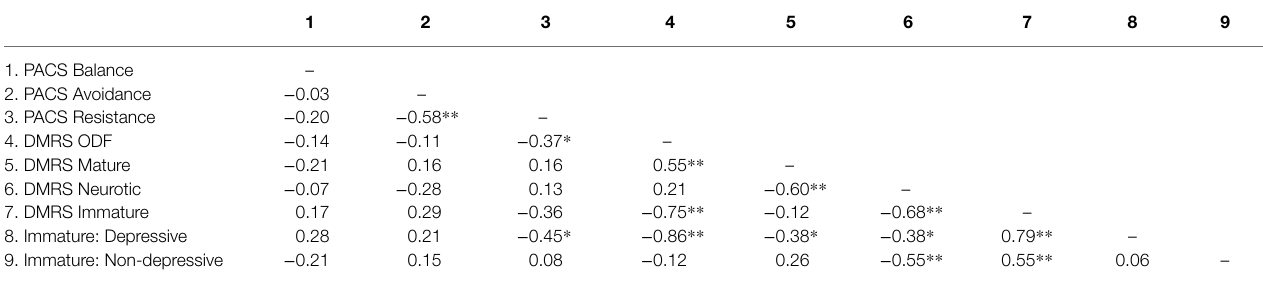
TABLE 2 | Spearman correlations between early PACS attachment-related characteristics and early DMRS defense mechanisms.